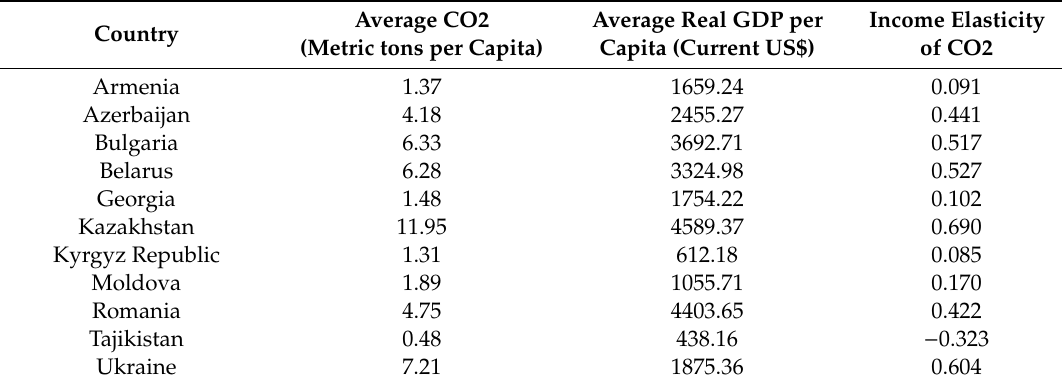
Table 2. Income elasticity of CO2 emissions for individual countries in Eastern Europe and Central Asia. Average CO2 Country (Metric tons per Capita)